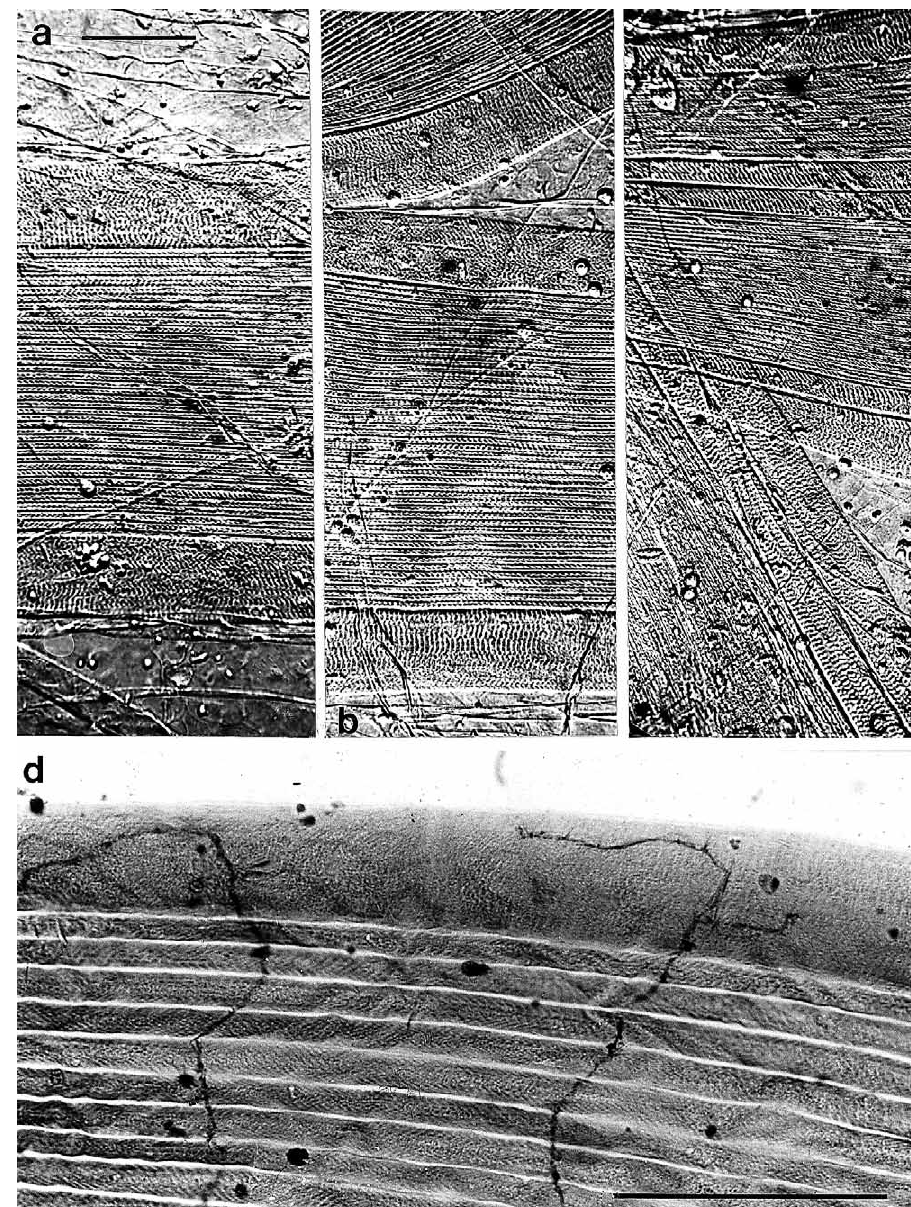
muscle band. Acetylcholinesterase method. Scale bar: 100